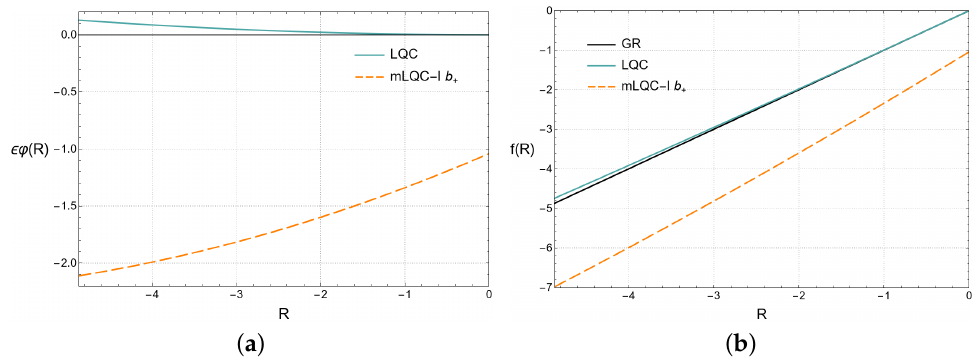
Figure 2. The plot ( a ) (Deviation, from GR, of the effective Lagrangian: a comparison between the b + branch of mLQC-I and LQC) presents the comparison between Equation (51), for the b + branch of mLQC-I (dashed light orange line), and Equation (35), for LQC (solid blue line), with c 1 = c 2 = 0, for − 2 κρ I c ≤ R ≤ 0. Contrary to the previous case, for this branch the correction is dominated by the linear term. As a result, since R ≤ 0, the deviation is predominantly negative. The plot ( b ) (Effective f ( R ) function: a comparison between the b + branch of mLQC-I, LQC, and GR) illustrates the differences between the Lagrangian density of GR (solid black line), with Λ = 0, and the effective Lagrangian densities given by Equation (36), in the case of LQC (solid blue line), and Equation (53), for the b + branch of mLQC-I (dashed light orange line), for the interval − 2 κρ I c ≤ R ≤ 0.